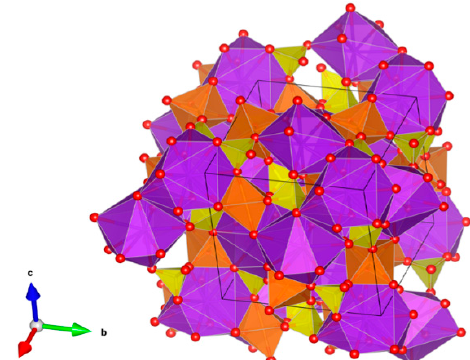
Figure 27. Langbeinite. K 2 Mg 2 (SO 4 ) 3 . Structure cubic, Sp. gr. P2 1 3. Cations can be Na, K,